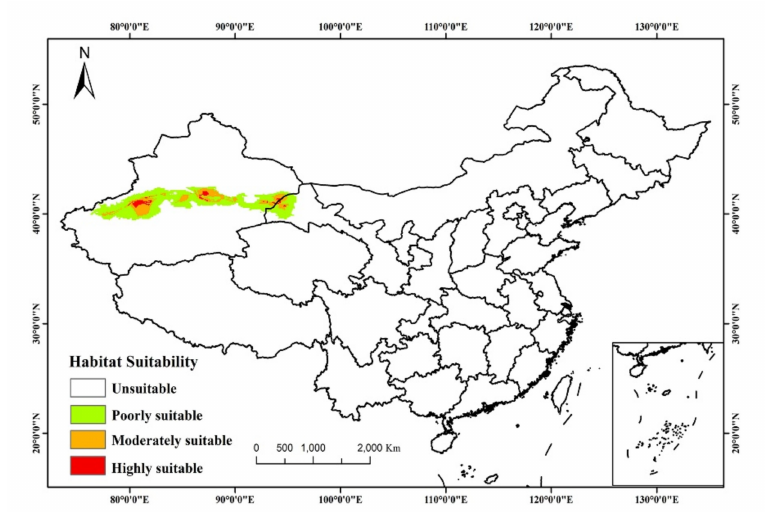
Figure 4. Present habitat distribution suitability of T. klimeschi